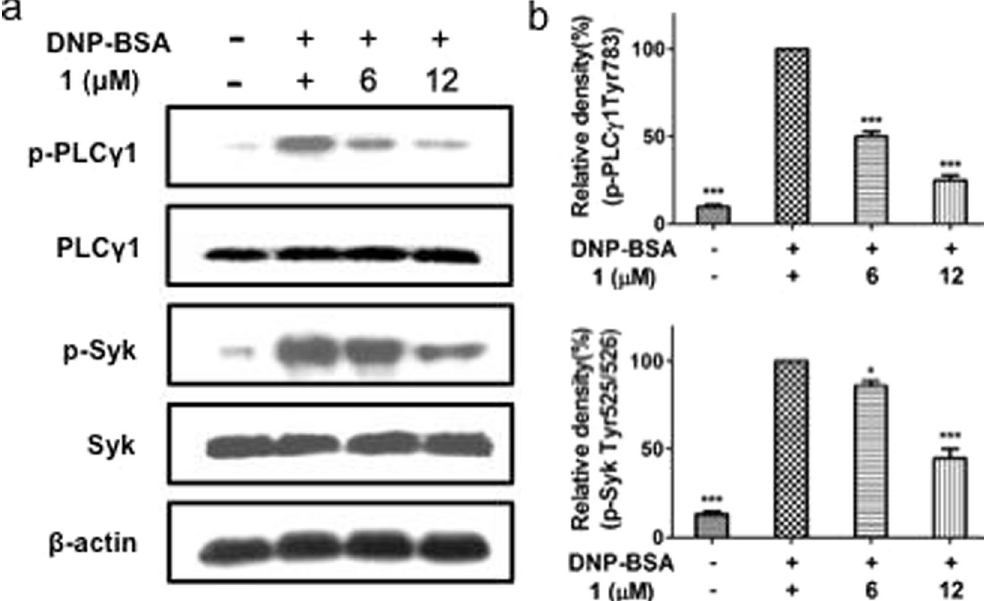
Figure 9. Comparison of the dysivillosin A ( 1 ) inhibited the activation of signaling molecules in antigen- stimulated RBL-2H3 cells. IgE-sensitized RBL-2H3 cells (2 × 10 6 cells/well) were stimulated with 1 μ g/ml DNP- BSA for 15 min in the presence or absence of 1 . The levels of p-Syk, Syk, p-PLC γ 1 and PLC γ 1 were measured by immunoblotting analysis. ( a ) The blots are representative of three independent experiments. ( b ) The data are presented as means ± SD. * P < 0.05, *** P < 0.001 versus DNP-BSA-treated group (n = 3). Data are analyzed by one-way ANOVA followed by Tukey’s Multiple Comparison Post-Test (GraphPad Prism